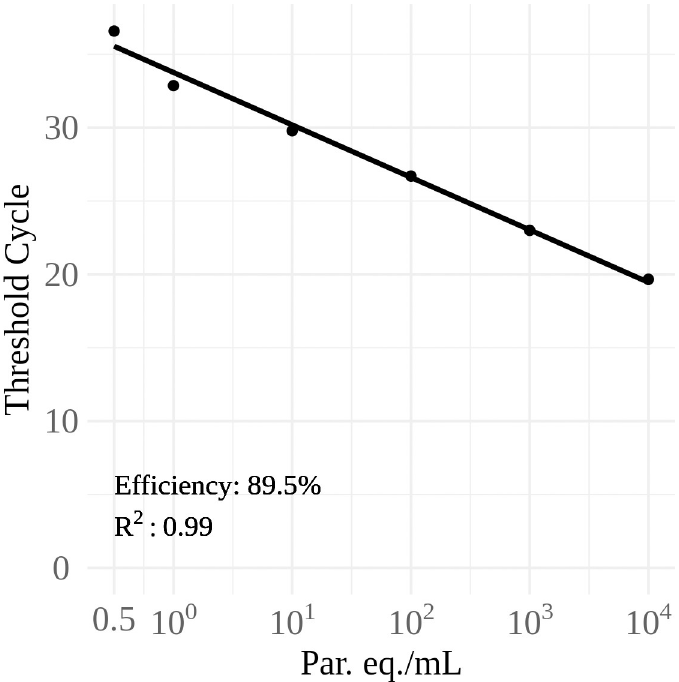
Fig 1. Dynamic range for Trypanosoma cruzi quantification by Real Time qPCR. TaqMan qPCR was carried out with serial diluted DNA extracted from blood spiked with T . cruzi [Y strain], ranging from 10 4 to 0.5 par. eq.⁄mL (parasite equivalent per milliliter of blood).